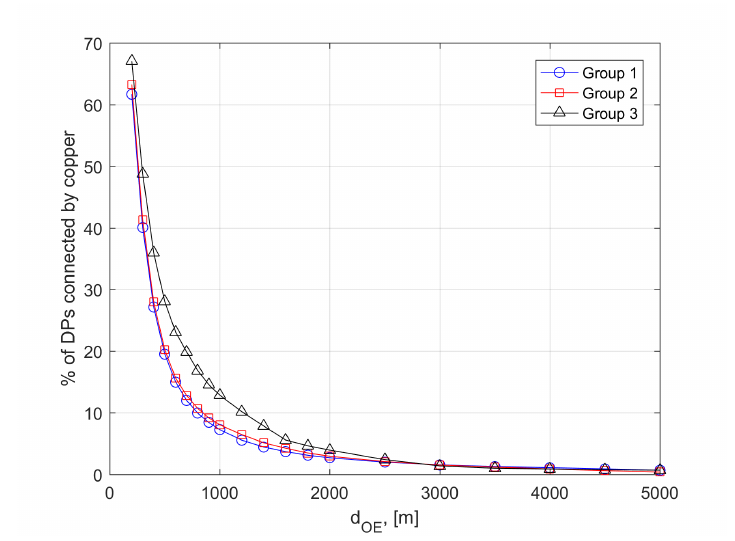
Figure 4. Percentage of distributors connected by copper to the new added Cabinets as a function of d OE and for the three groups of